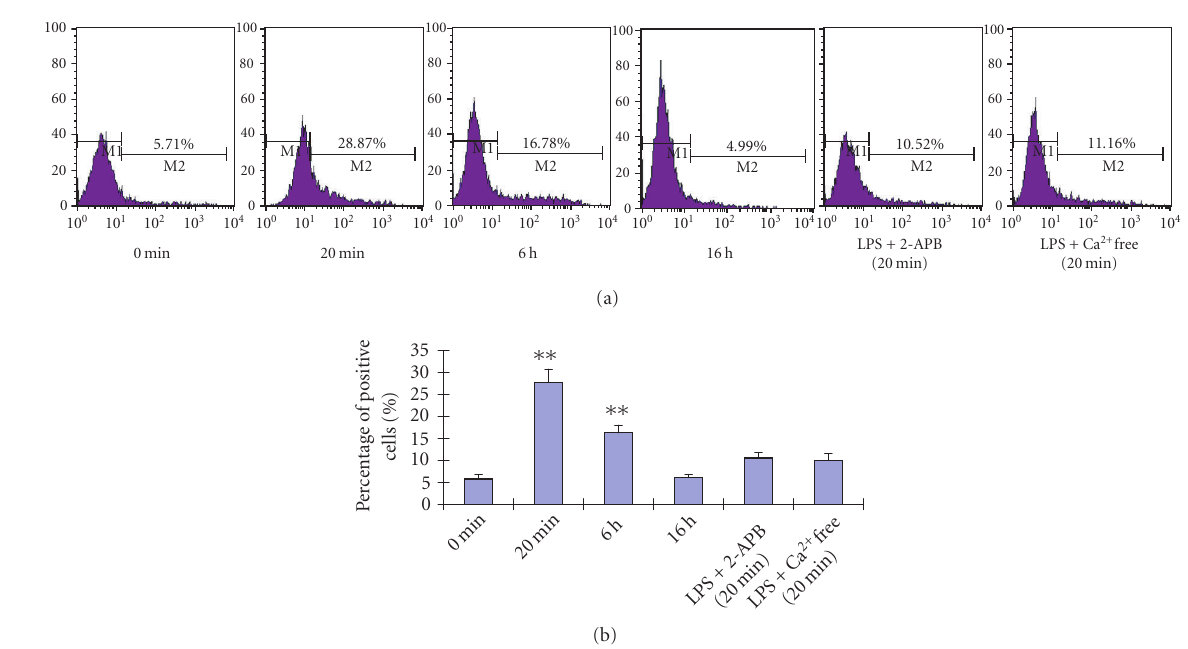
Figure 5: LPS-evoked Ca 2+ influx stimulated ROS production. (a) Flow cytometry profiles showing the time course of ROS production following stimulation with LPS (10 μ g/mL) in the presence of external Ca 2+ . Stimulation of ROS production with LPS (10 μ g/mL) at 20 minutes was suppressed in the absence of external Ca 2+ or when pretreated with 2-APB (20 μ M) in the absence of external Ca 2+ . Figure 5(a) is representative of three experiments performed on di ff erent experimental days. (b) Aggregate data are summarized. TG: thapsigargin. P < . 01 versus control group. (cid:0)(cid:0)